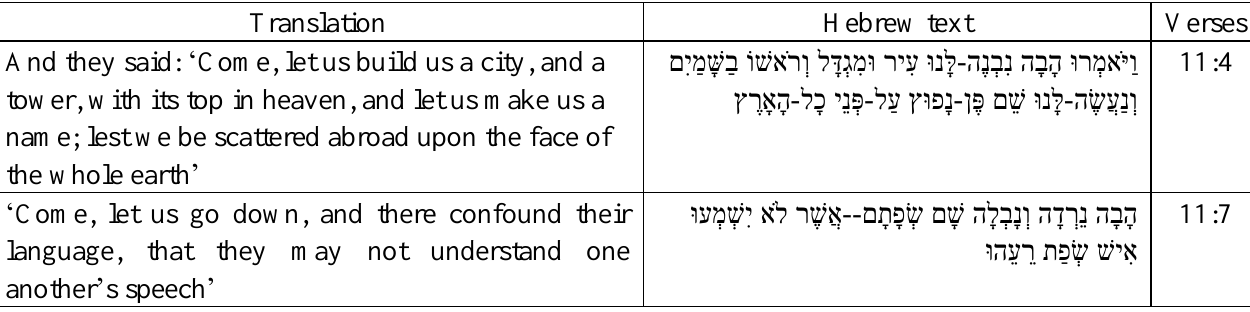
Table 1. Hebrew text and translation of Gn